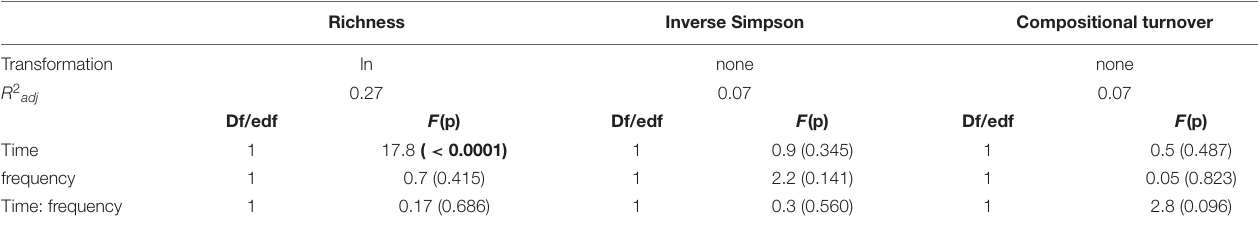
TABLE 2 | Results of the linear mixed models (LMMs) for phytoplankton compositional structure (species richness, inverse Simpson diversity index, compositional turnover). Richness Inverse Simpson Compositional